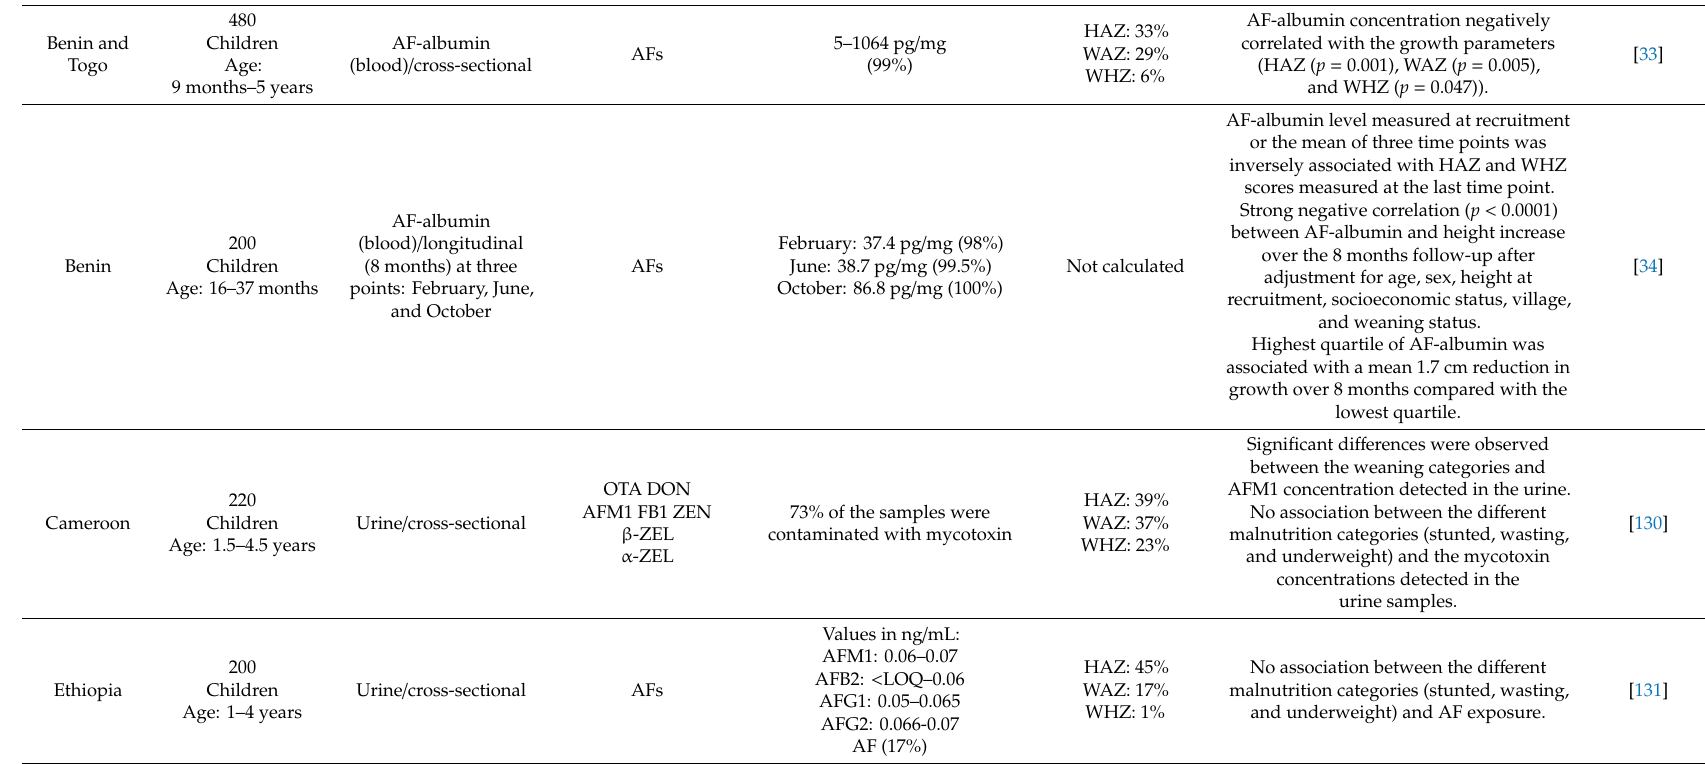
Table 5. Summary of studies on relationships between mycotoxin exposure and child growth in sub-Saharan Africa.